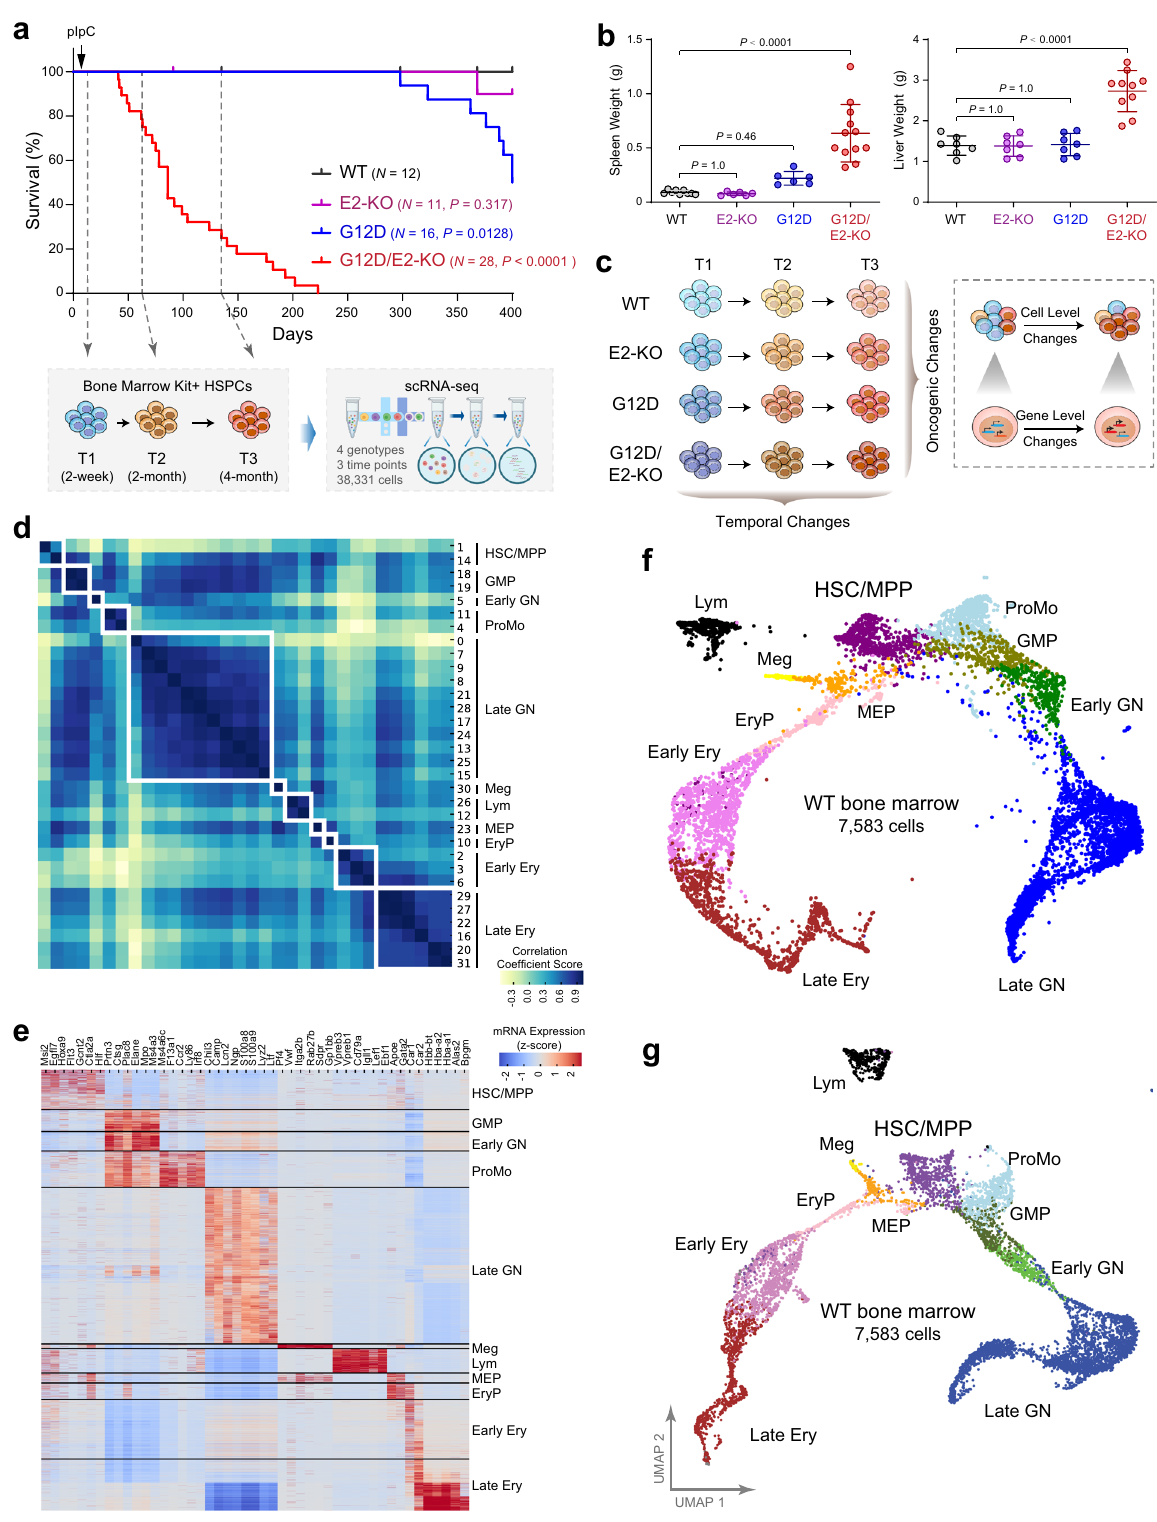
underlying leukemia progression, we developed a custom pipeline to process scRNA-seq data, annotate cell populations, infer developmental hierarchies, and evaluate oncogenic cooperation at single-cell and single-gene levels (Supplementary Fig. 1b). We fi rst identi fi ed baseline cellular heterogeneity in BM HSPCs from healthy (WT) mice at time points consistent with evolving leu- kemia development (T1 – T3; Fig. 1a, c). Total 7583 cells from WT